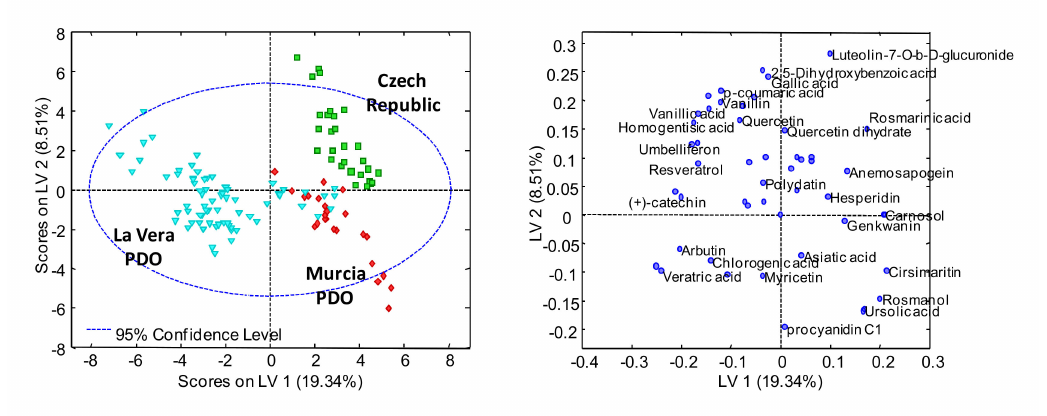
Figure 4. Partial least squares regression-discriminant analysis (PLS-DA) score and the loading plots of LV1 vs. LV2 for the classification of the analyzed paprika samples, according to their PDO and production